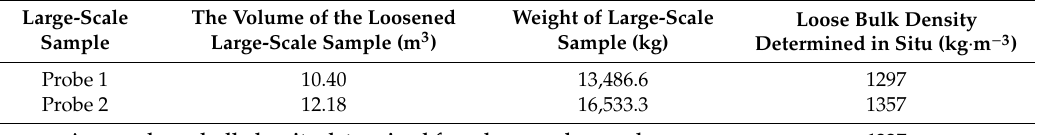
Table 7. Results of loose bulk density in situ determination on large-scale samples.